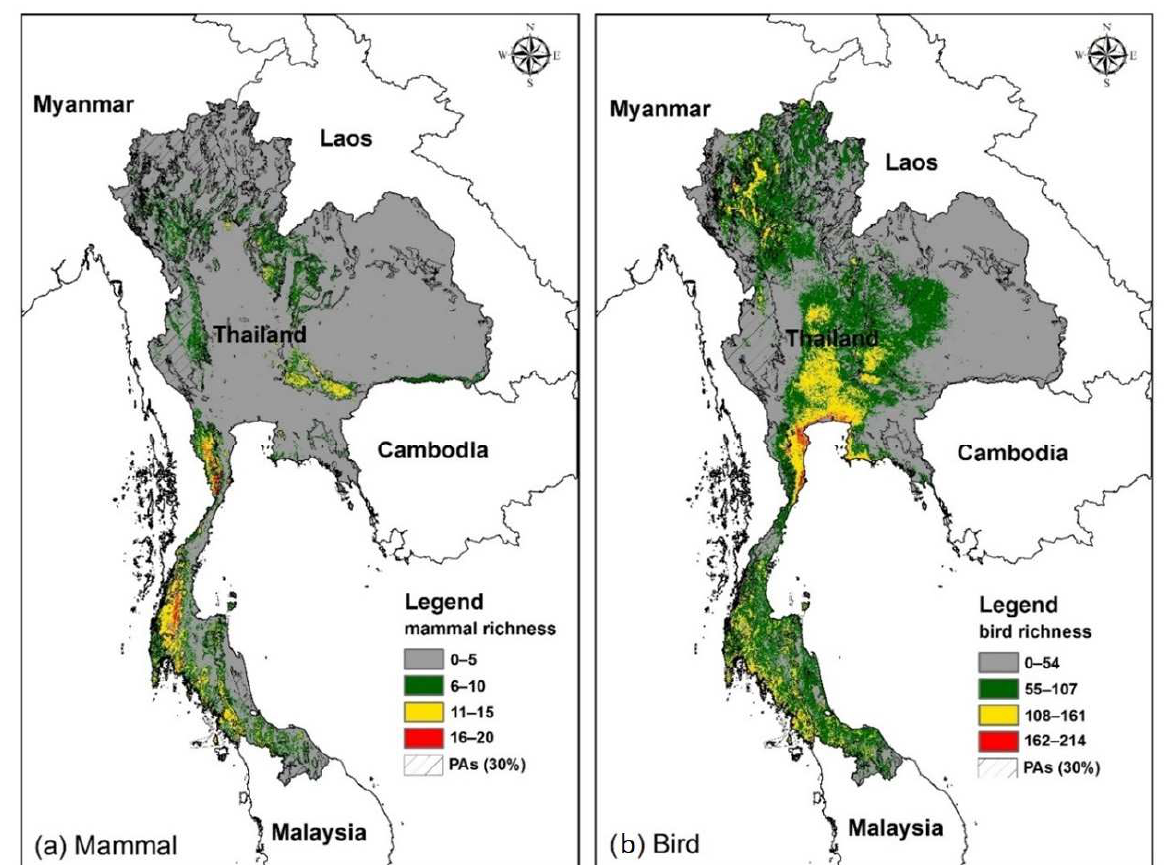
Figure 3. Numbers of mammal and bird species (out of the 80 and 702 spp. modeled, respectively) which did not meet representation targets for the percentage of each species’ modeled range in Thailand in the expanded protected area system.